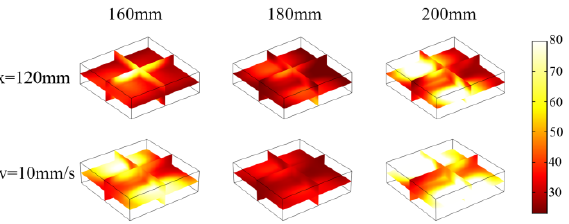
Figure 13. Temperature distribution comparison of potato fixed heating at x = 120 mm and translating at 10 mm/s (unit: °C).